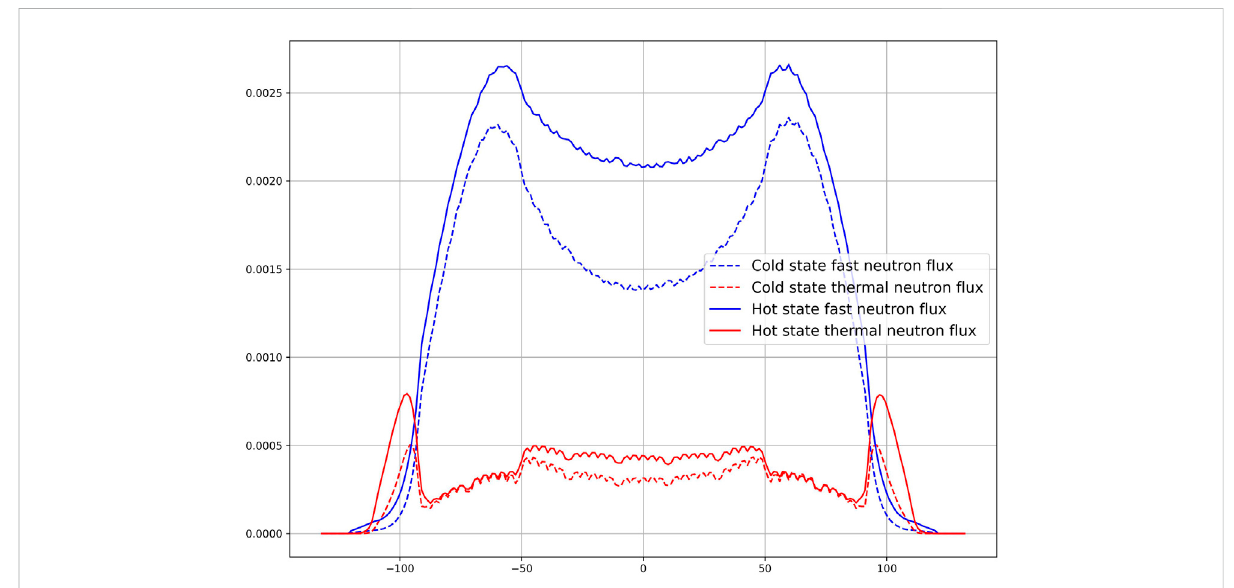
FIGURE 6 Cold and hot state neutron fl ux distribution viewed along a diameter in the X-axis